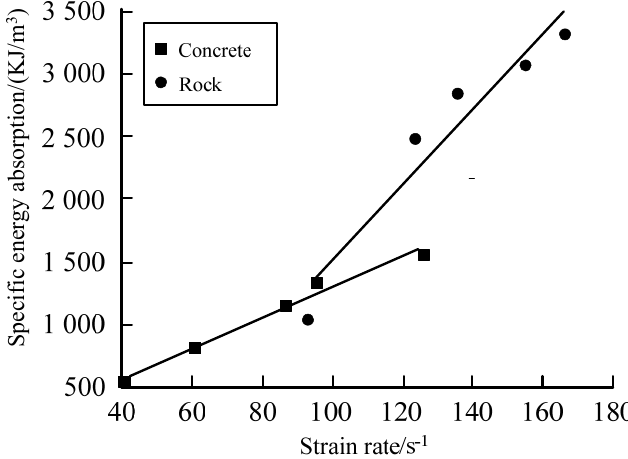
Figure 5: Correlation between specific energy absorption and strain